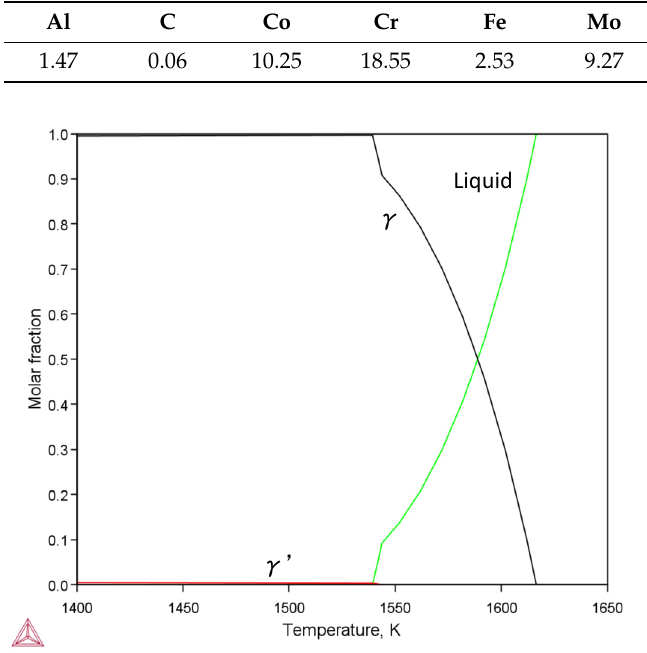
Table 2. Composition of the Ni-based alloy in this study (wt%).